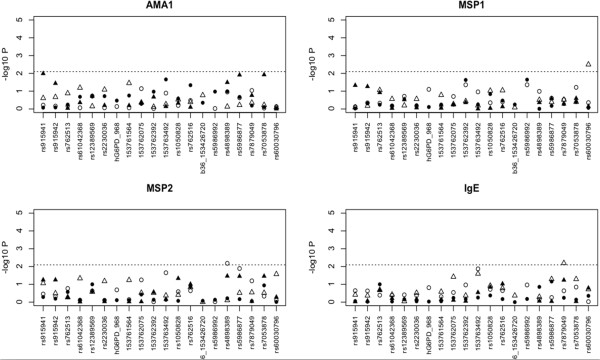
Association analyses for the immunological titres.